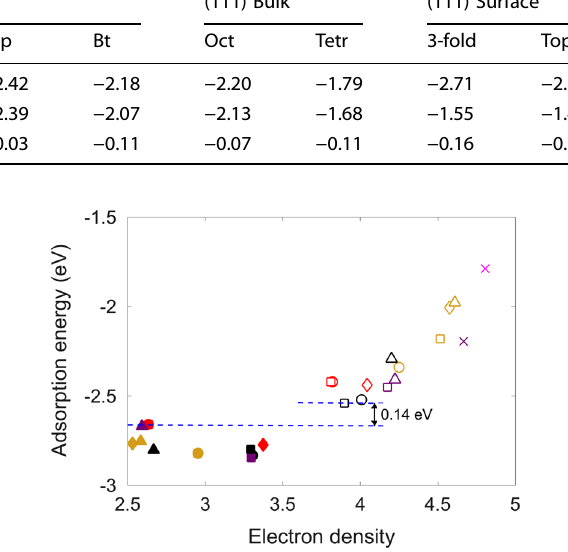
adsorption sites. The adsorption sites in the bulk lattice are represented by cross symbols. The adsorption sites on the GBs and corresponding separated surfaces are respectively represented by hollow and solid symbols , including ∑ 5(310)[001]( circle ), ∑ 17(140) [001]( square ), ∑ 11 (113)[011]( diamond ), and ∑ 27(115)[011]( triangle ). The color of symbols indicates the type of deltahedral units, with the same edge coloring scheme in Fig. 1a, i.e., pink : tetrahedron; yellow : bi-tetrahedron; purple : for octahedron; black : pentagonal bi-pyramid; and red : capped trigonal